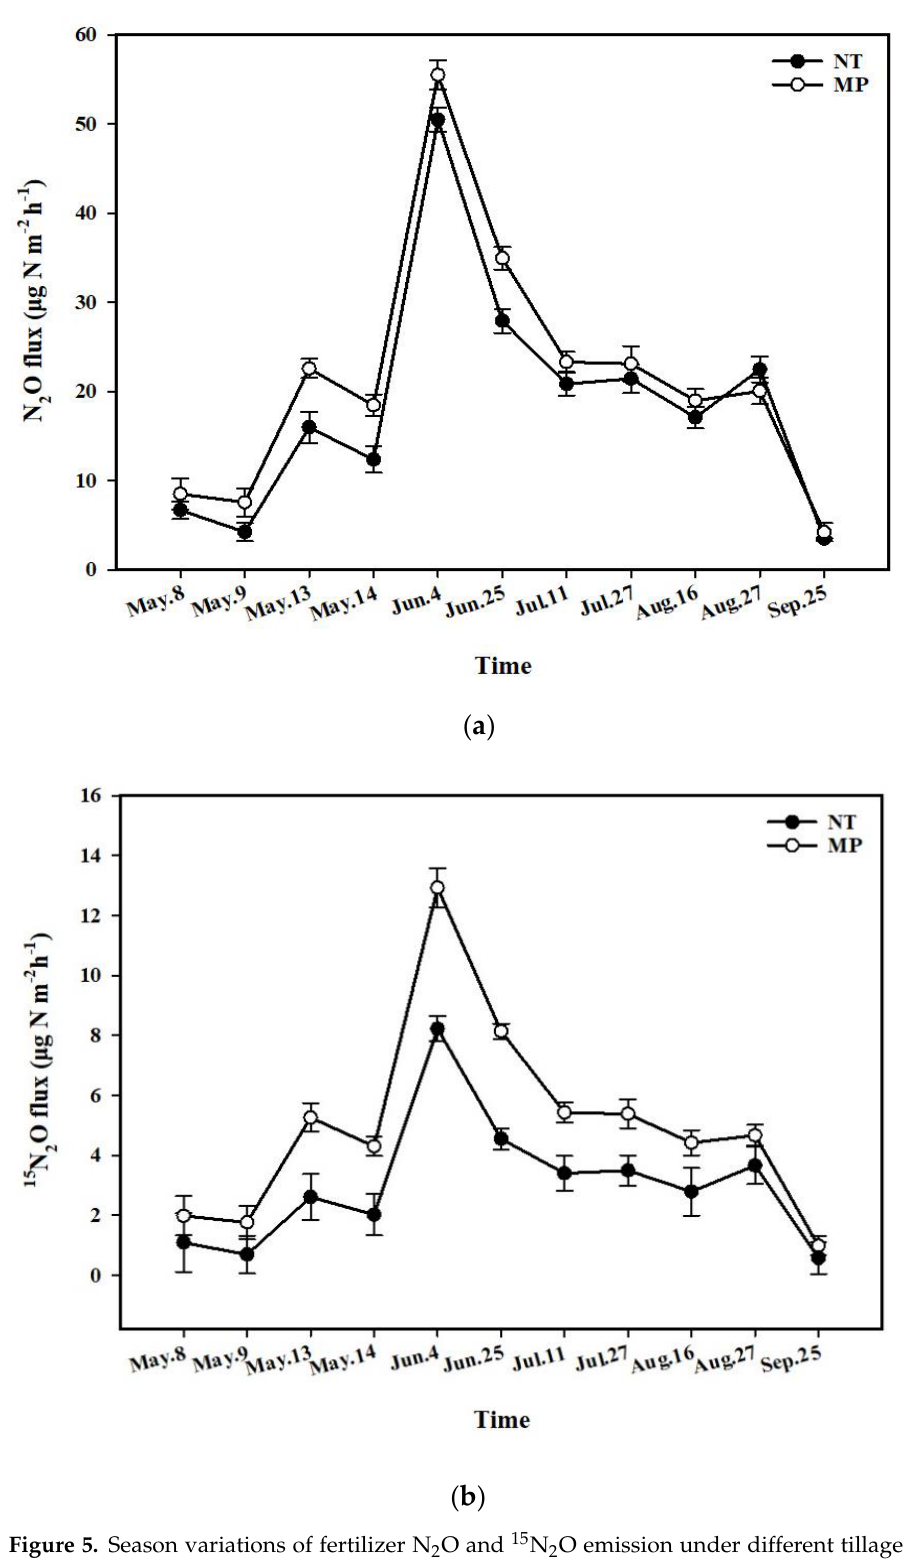
Figure 5. Season variations of fertilizer N 2 O and 15 N 2 O emission under different tillage practice. ( a ) Season variations of fertilizer N 2 O emission under different tillage practice. ( b ) Season variations of fertilizer 15 N 2 O emission under different tillage practice. Table 2. The growing season emission of N 2 O and fertilizer 15 N 2 O under different tillage practices. Treatment